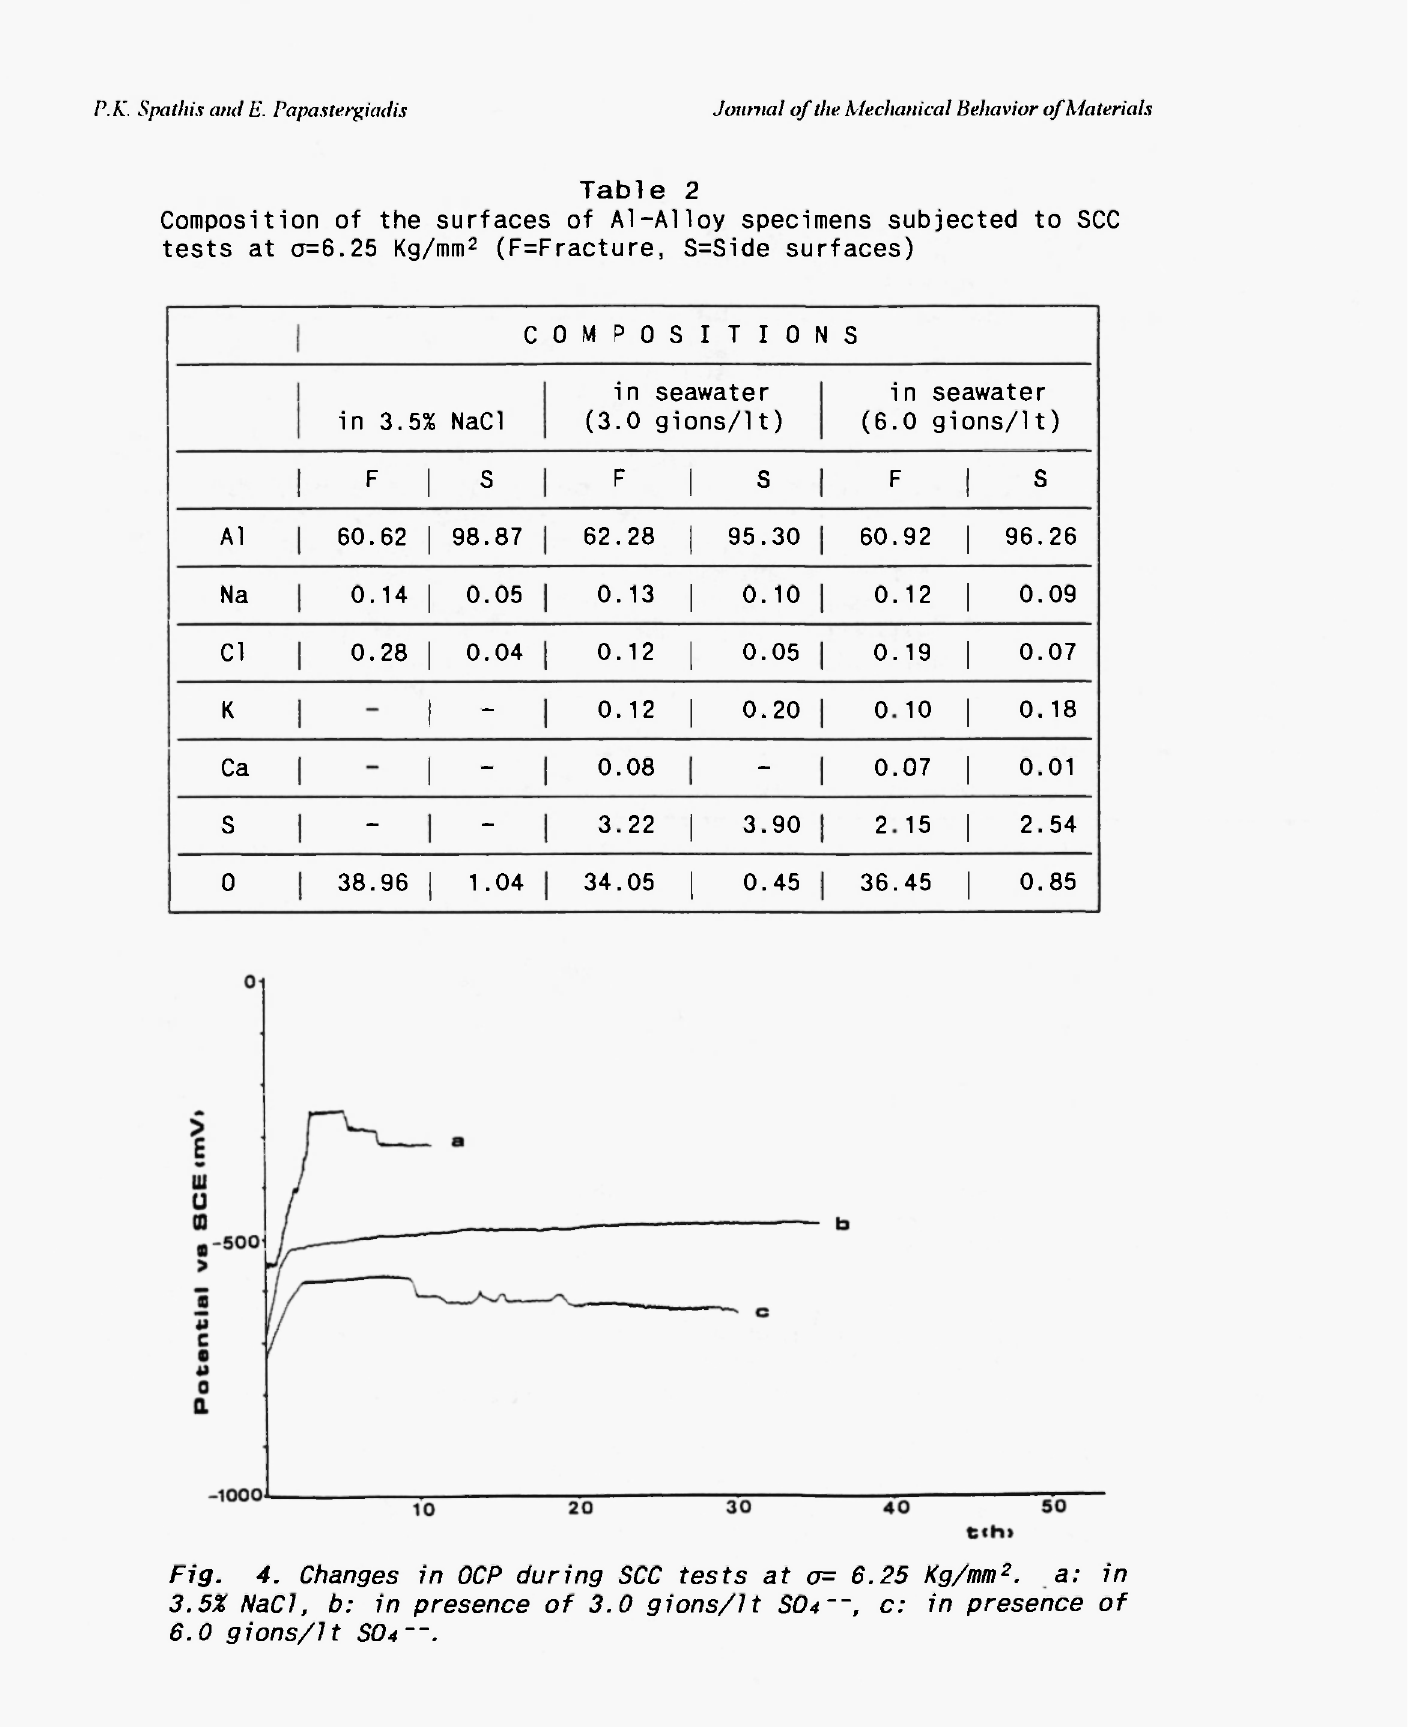
Fig. 4. Changes in OCP during SCC tests at σ= 6.25 Kg/mm 2 , a: in 3.5% NaCl, b: in presence of 3.0 gions/lt S04~~, c: in presence of 6.0